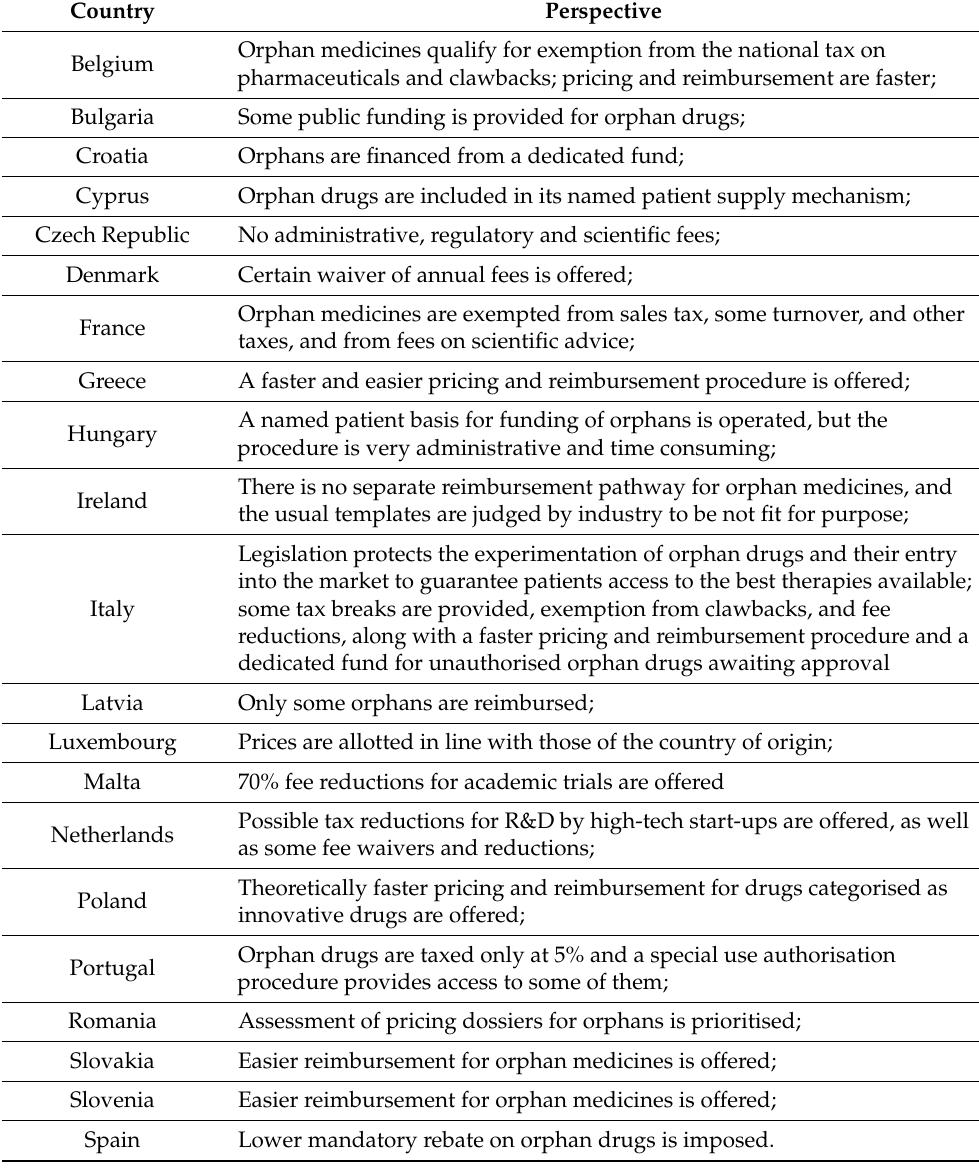
Table 1. Different national perspectives in orphan